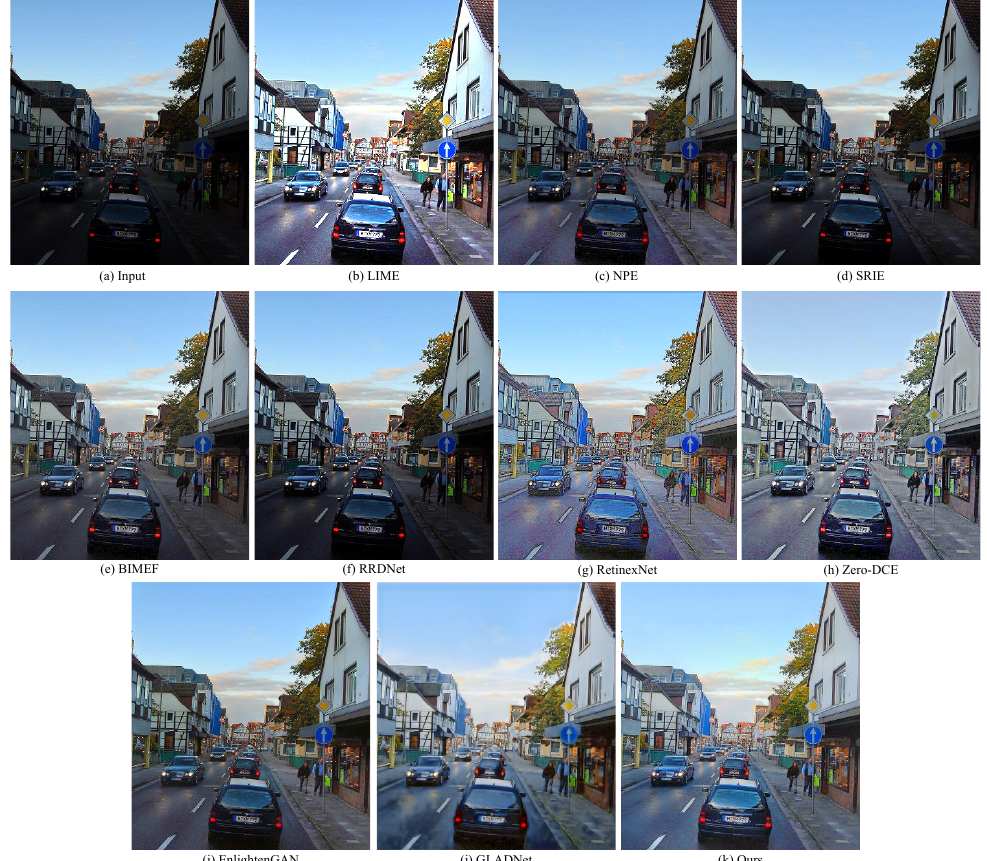
Figure 11. Visual comparisons of different methods on a real image from LIME